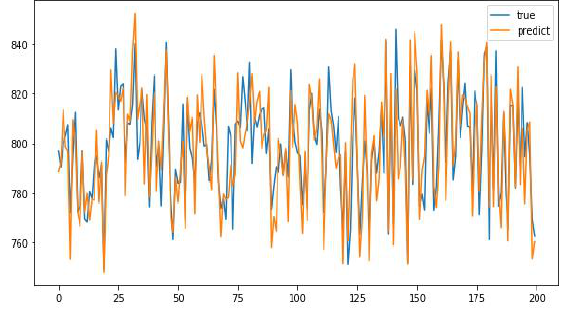
( f ) BP network prediction curve Figure 8. Comparison of algorithm results. The prediction results of 10 randomly selected groups of prediction models are shown in Table 8 below. Table 8. Model prediction results. BP